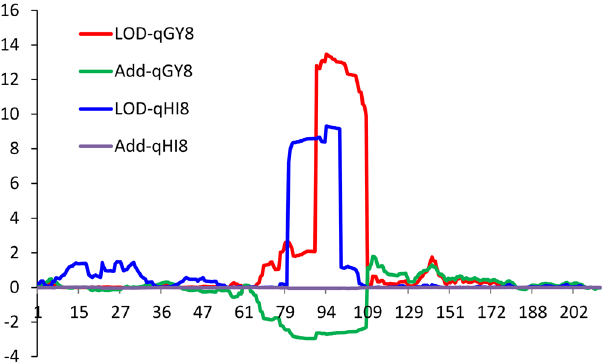
Figure 5. Co-localization of qGY8 and qHI8 .The value of LOD and corresponding additive effect for the trait of grain yield per plant (GY) and harvest index (HI) on chromosome 8 were shown. Y axis indicates LOD value or additive effect. X axis indicates the bin numbers on chromosome 8.